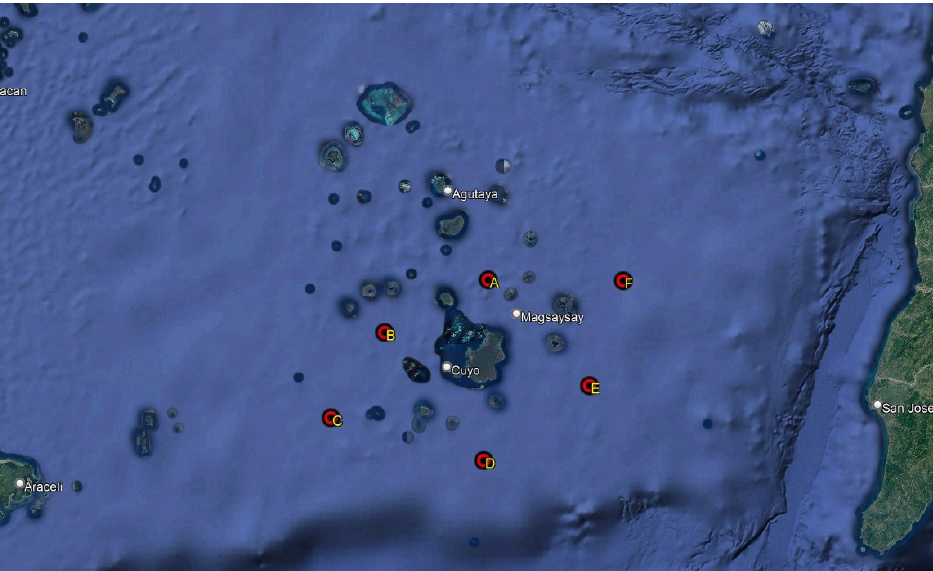
Figure 4. Chosen sites of interest (stations A–F) about 23 km from PAGASA station used to match with WEC to determine the potential annual energy production surrounding the island.